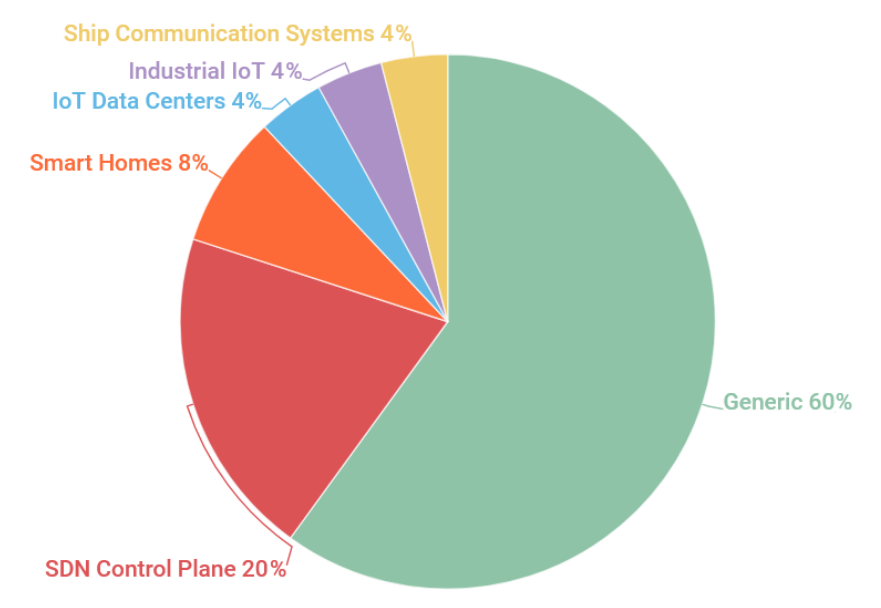
Figure 3. Distribution of mitigation solutions for IoT